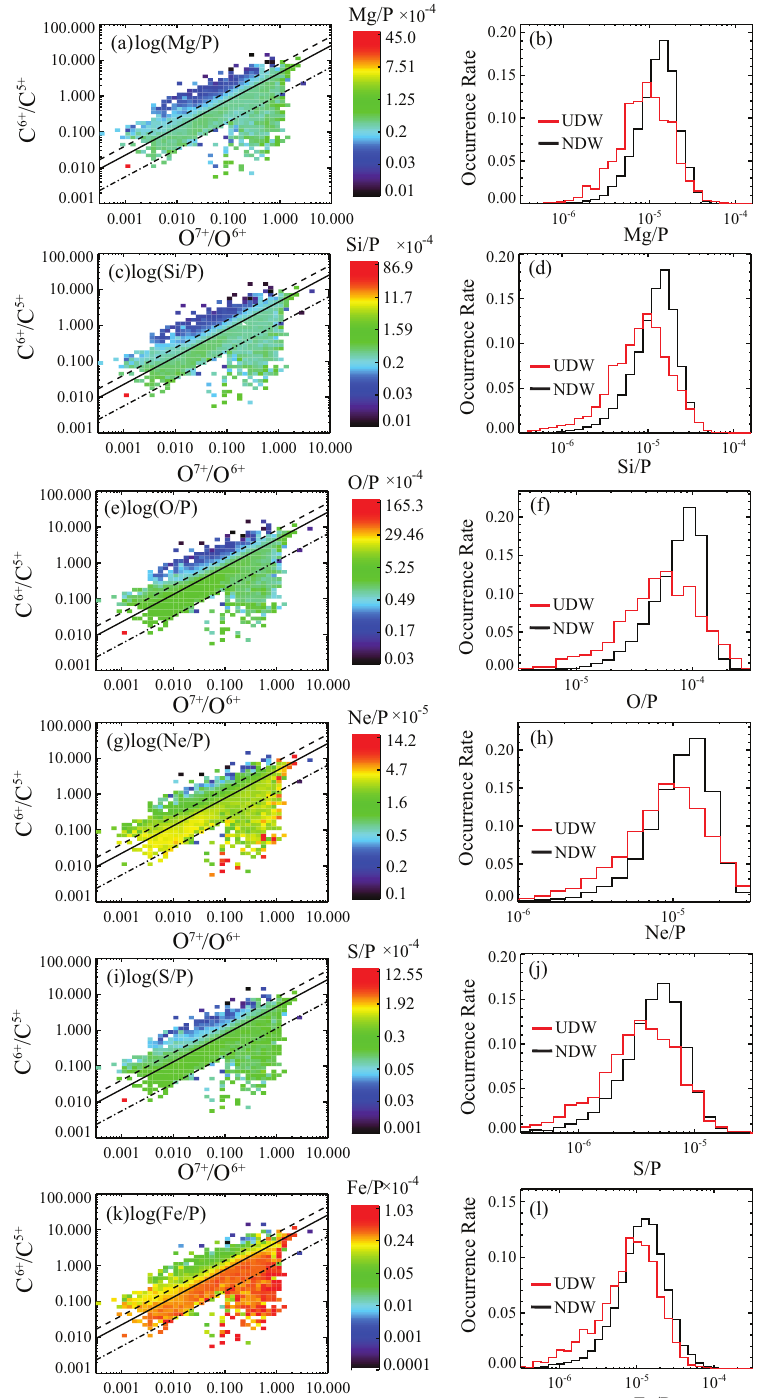
Figure 3. (Left) distributions of all non-ICME solar wind (January 1998–August 2011). ( a ) Mg/P, ( c ) Si/P, ( e ) O/P, ( g ) Ne/P, ( i ) S/P, and ( k ) Fe/P in the log(C 6 + /C 5 + ) and log(O 7 + /O 6 + ) space. The black solid line is the linear fit of the whole solar wind distribution in 2007, the dashdotted black lines are the threshold by which the Outliers are selected (see Zhao [13] for details). The dashed black lines on the upper-boundary of this plot are one of the thresholds we use to select the UDW in this study. ( Right ) histograms of the Mg/P ( b ), Si/P ( d ), O/P ( f ), Ne/P ( h ), S/P ( j ), and Fe/P ( l ) ratios in the UDW (red) and NDW